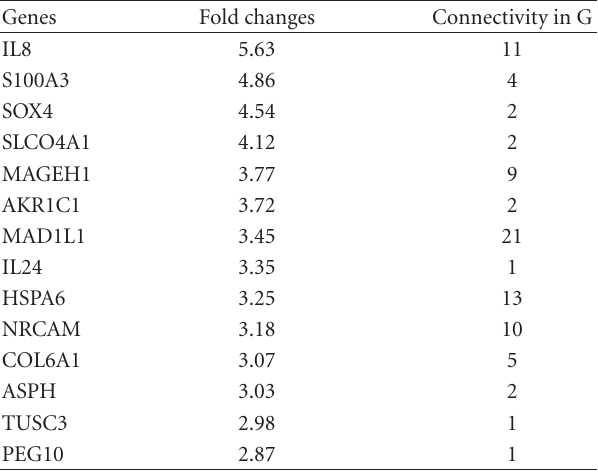
Table 1: The high ranking 14 up regulated genes based on the fold changes. For each gene in the list the connectivity in the protein interaction network G is given. None of the ranked upregulated genes are hub